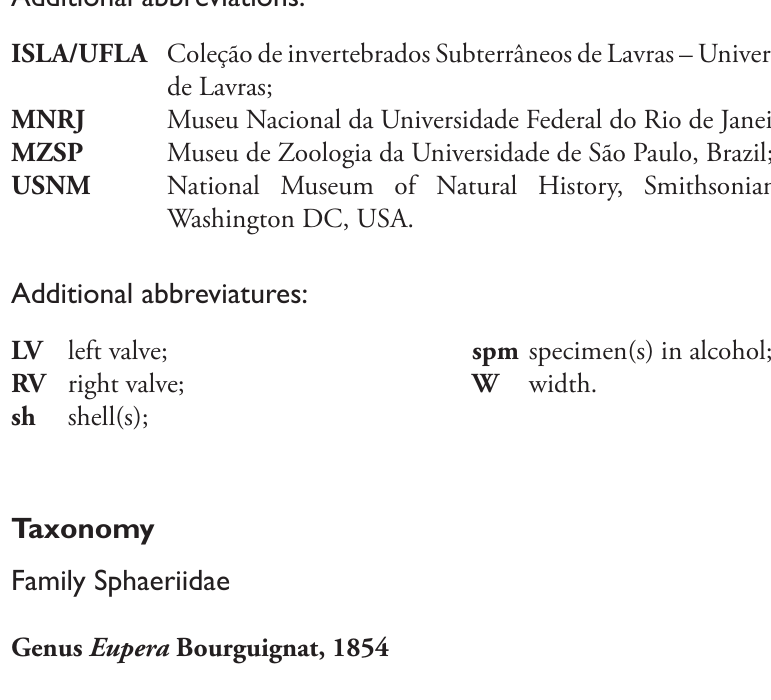
Material examined. Holotype . MZSP 155717. Paratypes MZSP 155716, 12 speci- mens, MNRJ 23647, 1 specimen, USNM, 1 specimen, all from type